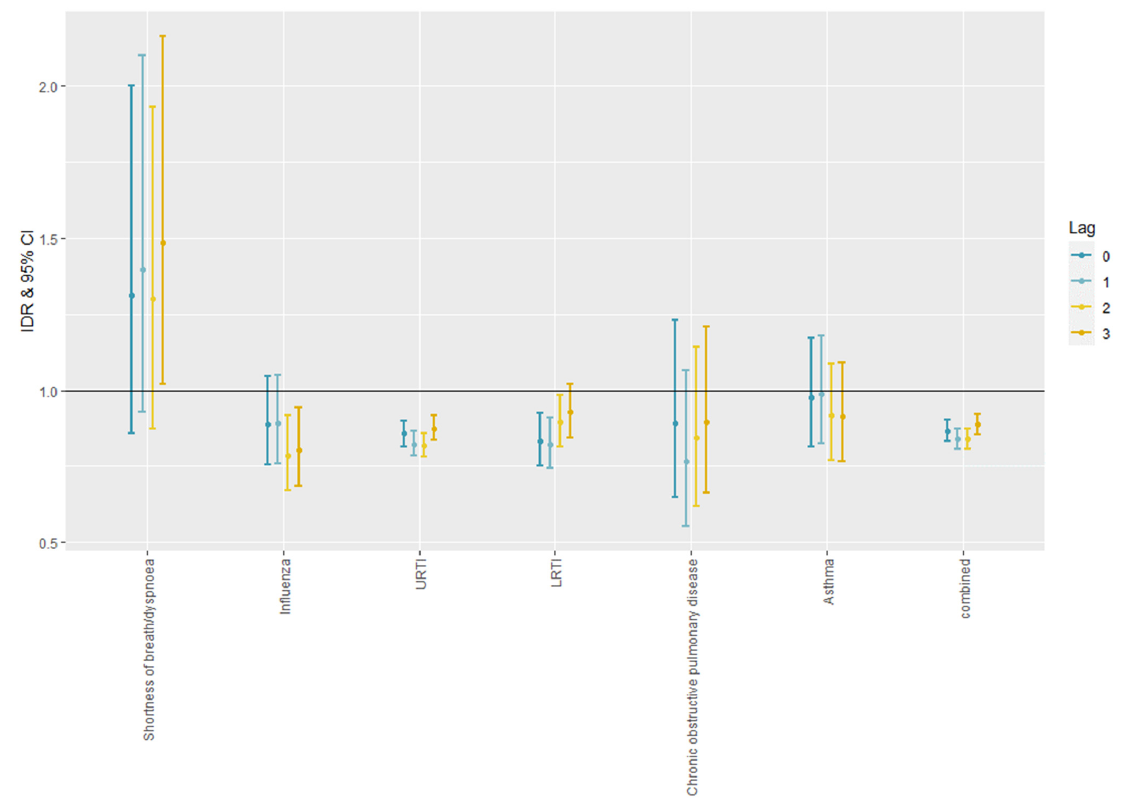
Figure 4. The IDRs with 95% CI for respiratory